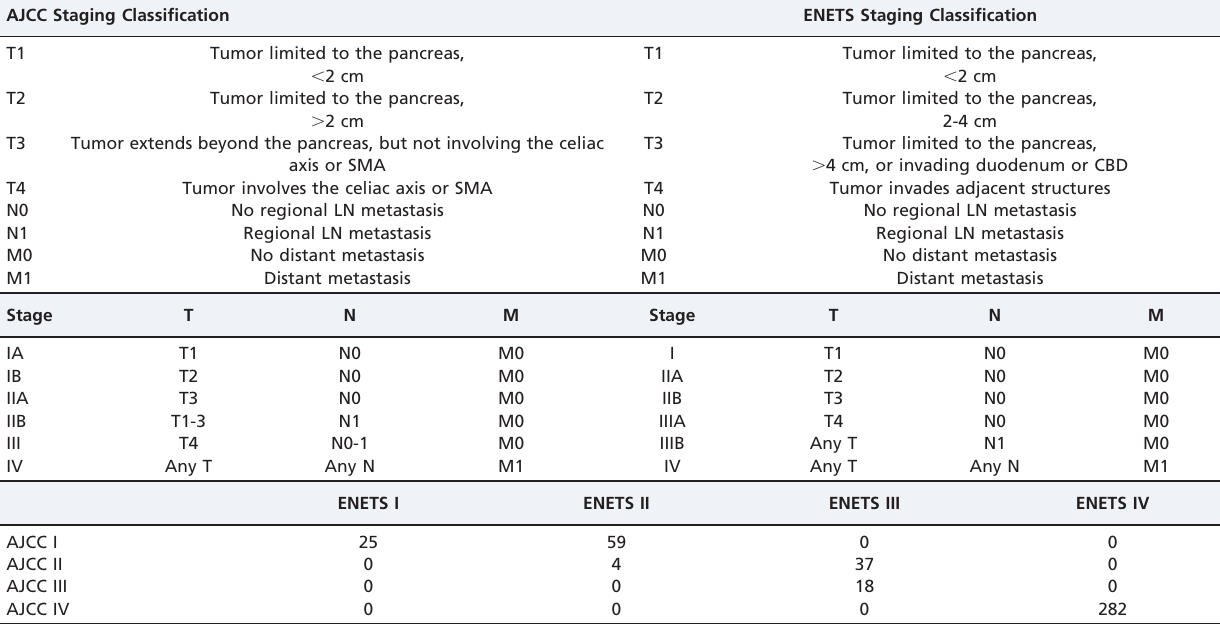
Table 1 - The American Joint Committee on Cancer (AJCC) and European Neuroendocrine Tumors Society (ENETS) staging classifications for pancreatic neuroendocrine tumors with cross-tabulation of stage